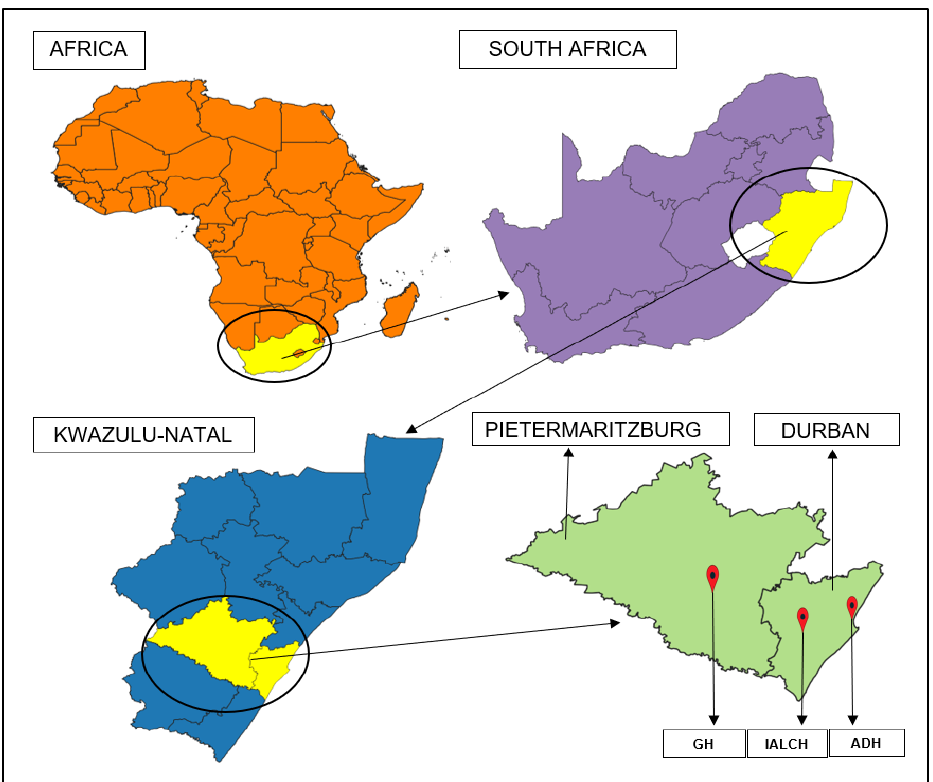
Figure 1. Location of the study sites within the broader regional context.